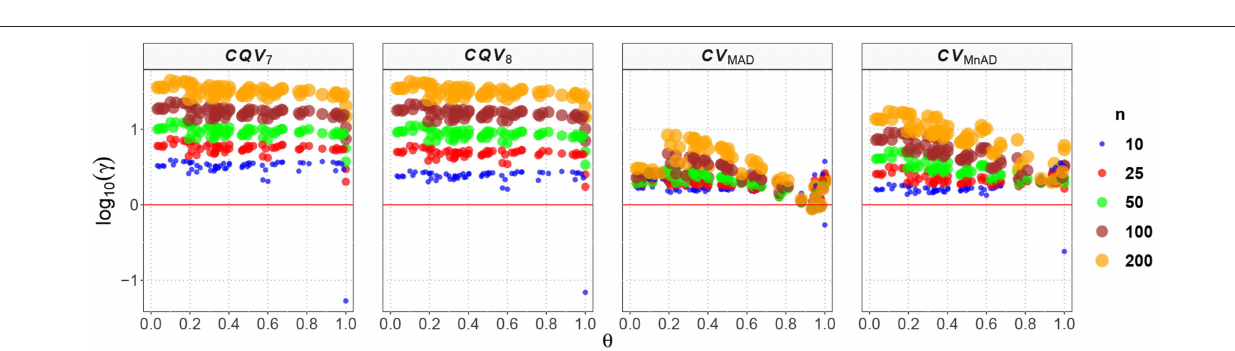
(0,1) produced for each estimator and sample size under the reparametrized ∈